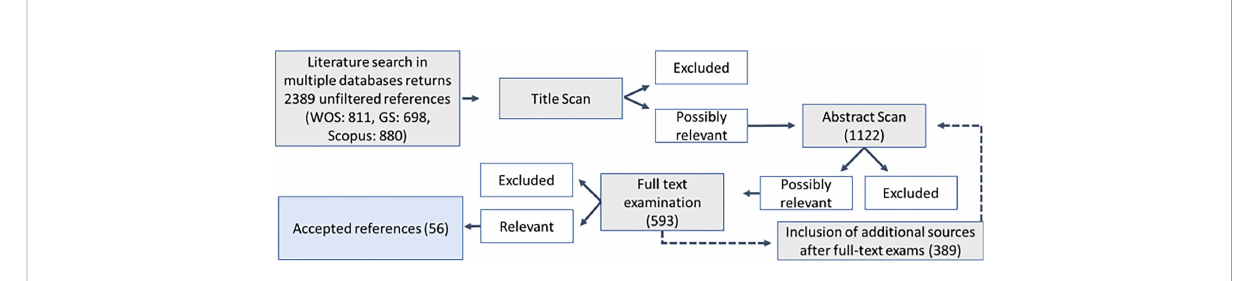
FIGURE 2 Flow chart for the systematic review process of literature retrieval and selection. Numbers indicate the number of papers per